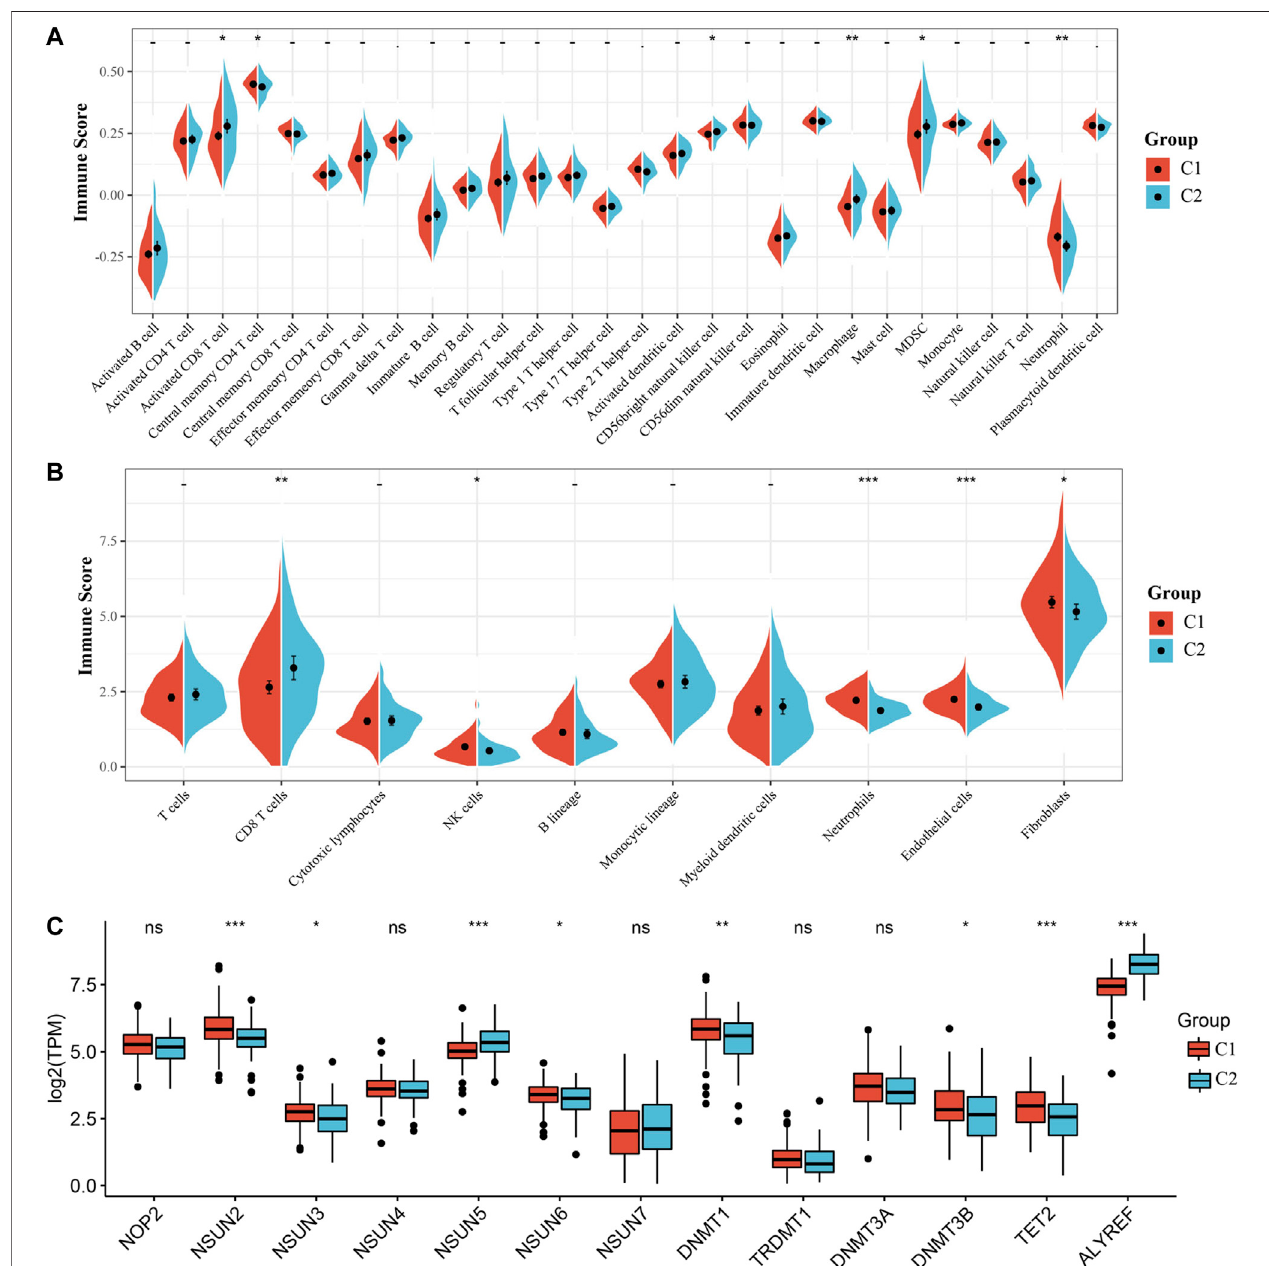
FIGURE3 | Immune in fi ltration analysisof them5C modi fi cation subtype. (A) Comparison of ssGSEA immune scorebetweenC1 and C2subtypes inthe TCGA all set. (B) Comparison of MCPcounter immune score between two subtypes in the TCGA all set. (C) Expression differences of 13 genes related to m5C modi fi cation between two